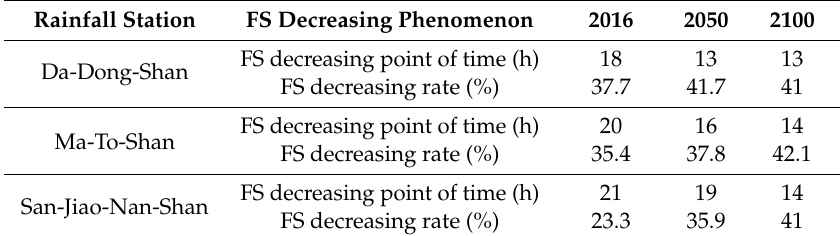
Table 5. The decreasing time and rate of slope Factor of Safety (FS) for the period 2016, 2050 and 2100. Rainfall Station FS Decreasing Phenomenon 2016